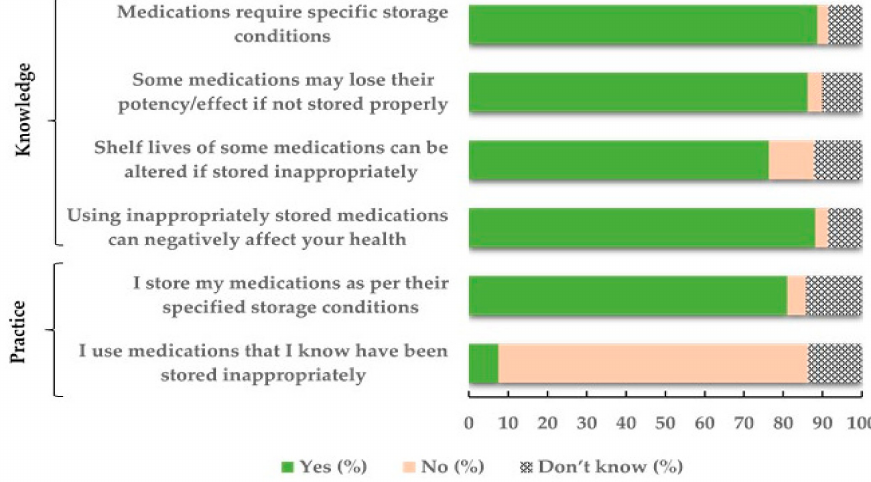
Figure 1. Hajj pilgrims’ knowledge and practice regarding medication storage. The overall mean medication storage knowledge score among pilgrims was 0.84 (SD = 0.29), with 68.2% of participants considered to have good knowledge according